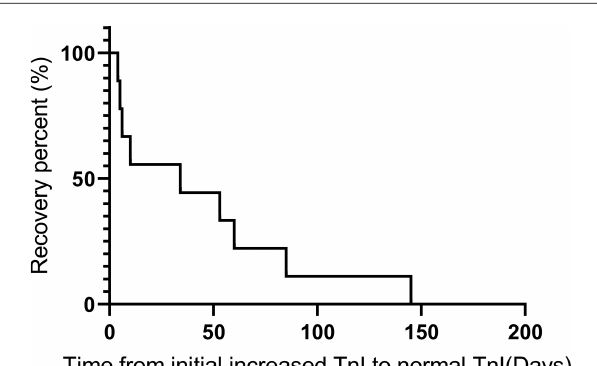
FIGURE 2 Recovery time from when the TnI level was initially increased to when a normal TnI level was obtained following corticosteroid and immune inhibitor